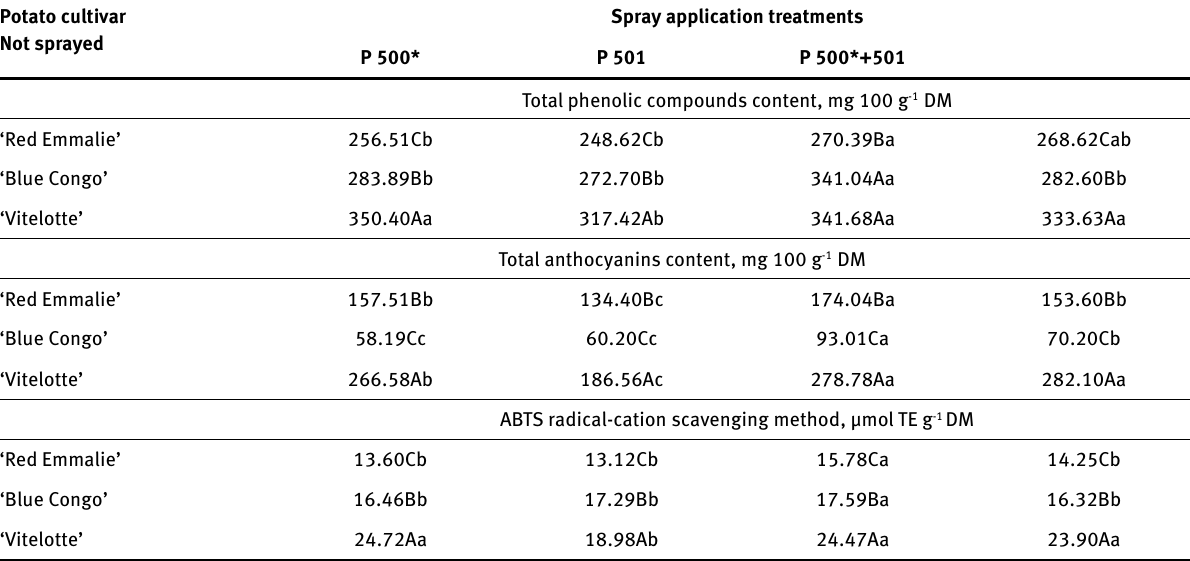
Table 3: The effect of BD preparations 500 and 501 on the total phenolic compounds content (TPCC), total anthocyanins content and antira- dical activity in potato tubers with colored flesh Potato